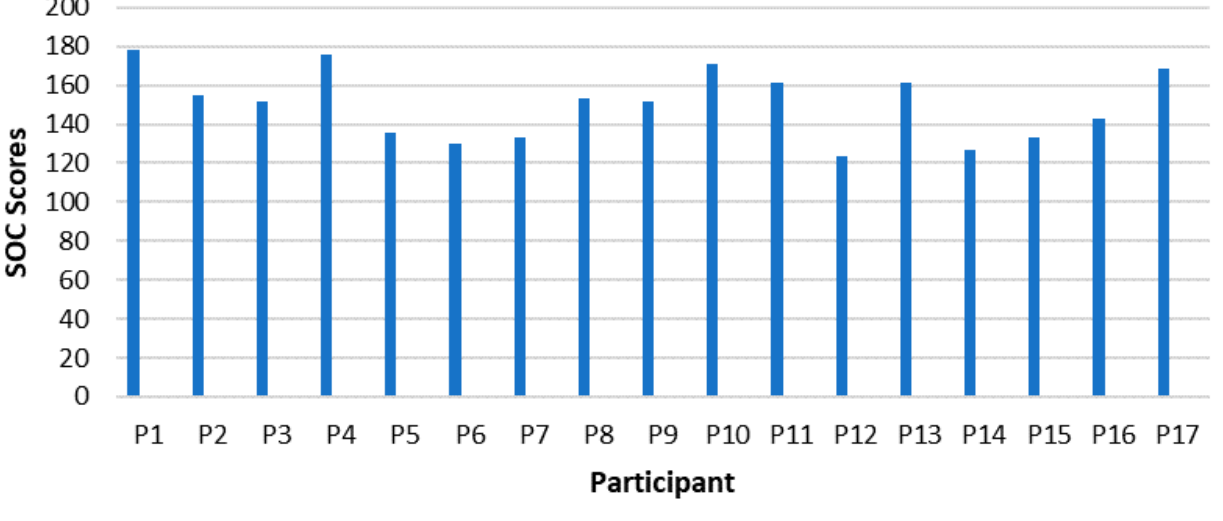
Figure 4. Total SOC Scores in Managers.